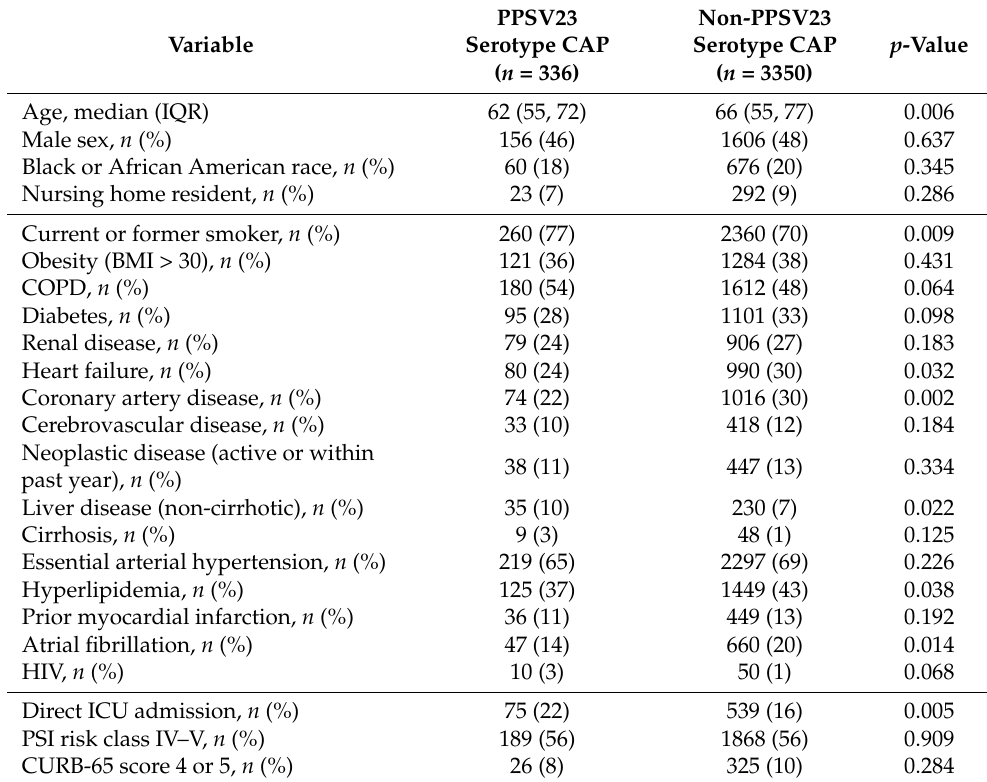
Table 2. Patient demographics, social and medical history between PPSV23-serotype CAP and non-PPSV23-serotype CAP